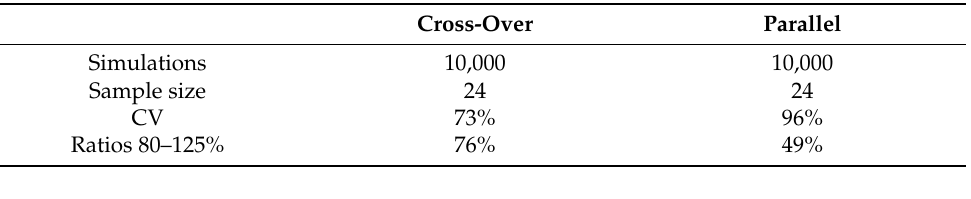
Table 2. Parameters used in simulations with calculated probability that the resulting ratio would fall into the range of 80–125%. CV: intra-subject for cross-over, total for parallel.